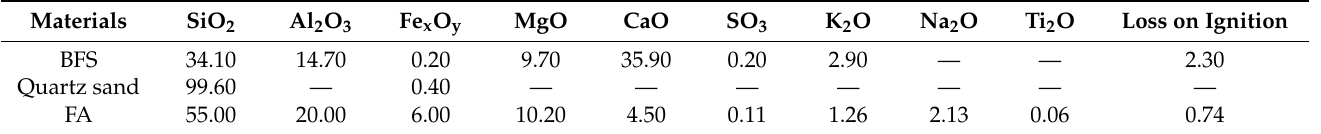
Table 2. The chemical composition of cement (%).